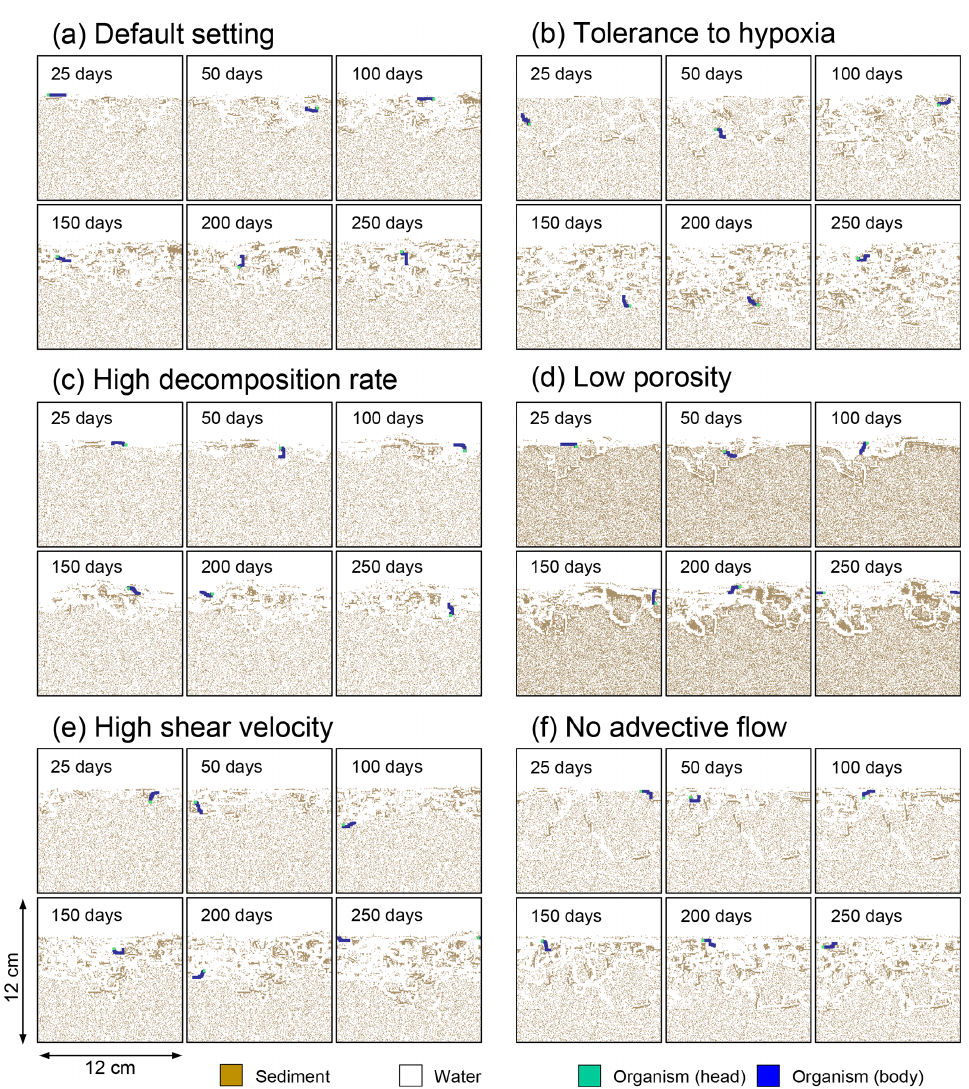
Figure 6. Time evolution of burrow geometry obtained from 1-year simulations with eLABS. See Sect. 3.1 and caption of Fig. 4 for the details of simulations (a–f) . Shown are burrow geometries at 25, 50, 100, 150, 200, and 250 model days from the start of the